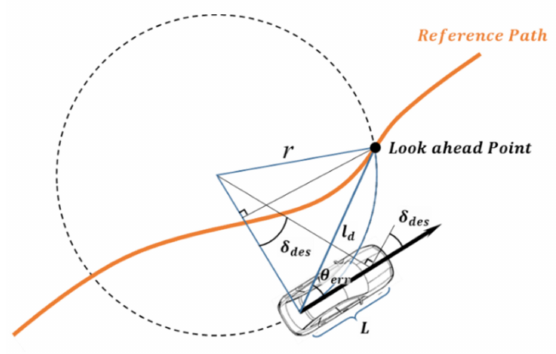
Figure 12. Geometry of pure-pursuit